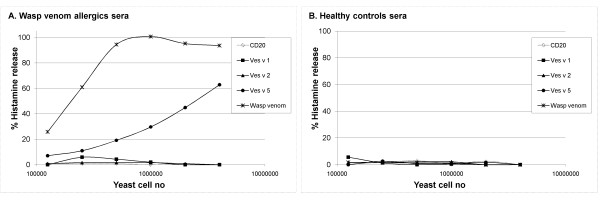
Basophil histamine release. Basophils sensitized with serum from wasp venom allergics (A) or healthy controls (B) were challenged with wasp venom and yeast cells expressing CD20, Ves v 1, Ves v 2 or Ves v 5 (from surface display vectors with zeocin-resistance markers). The results represent one experiment out of four. The wasp venom is diluted 3-fold in each step from the highest concentration of 222 ng venom extract per sample.